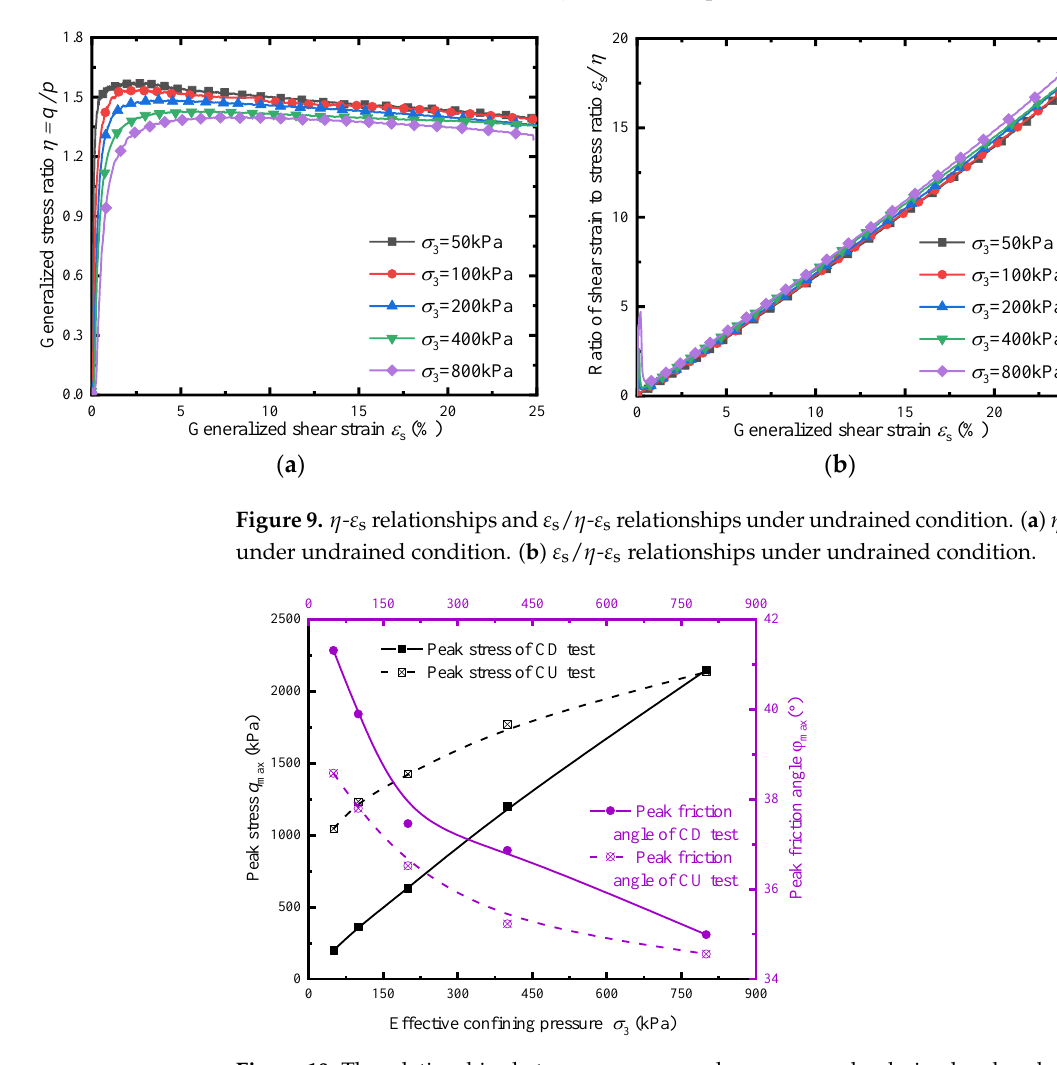
Figure 8. η - ε s relationships and ε s / η - ε s relationships under drained condition. ( a ) η - ε s relationships under drained condition. ( b ) ε s / η - ε s relationships under drained condition.